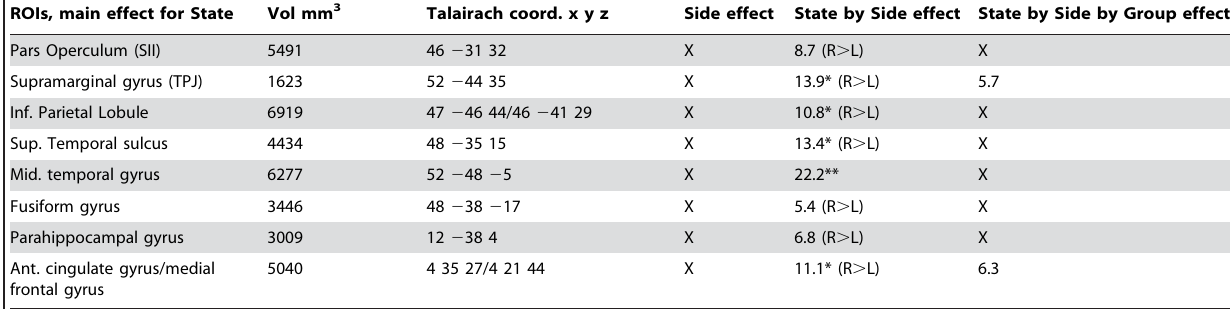
Table 4. Laterality